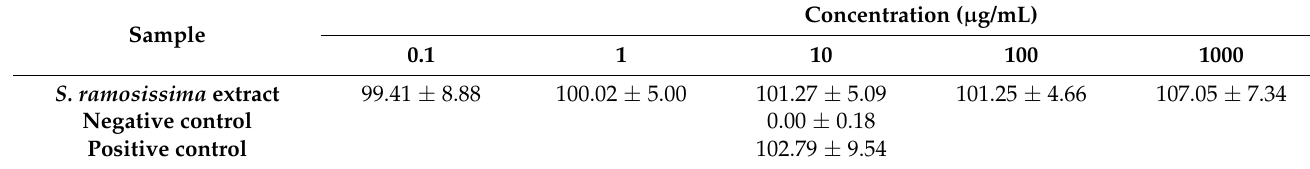
Table 5. Effects of S. ramosissima extract exposure on the viability (%) of HaCaT cell line at different concentrations, as measured by the MTT assay. Values are expressed as mean ± standard deviation ( n =